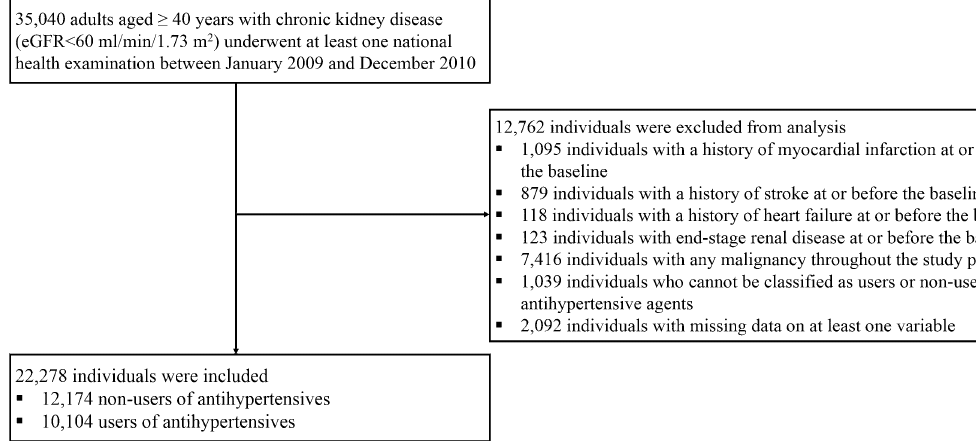
Figure 1. Flow diagram of the study population. Abbreviations: eGFR estimated glomerular filtration